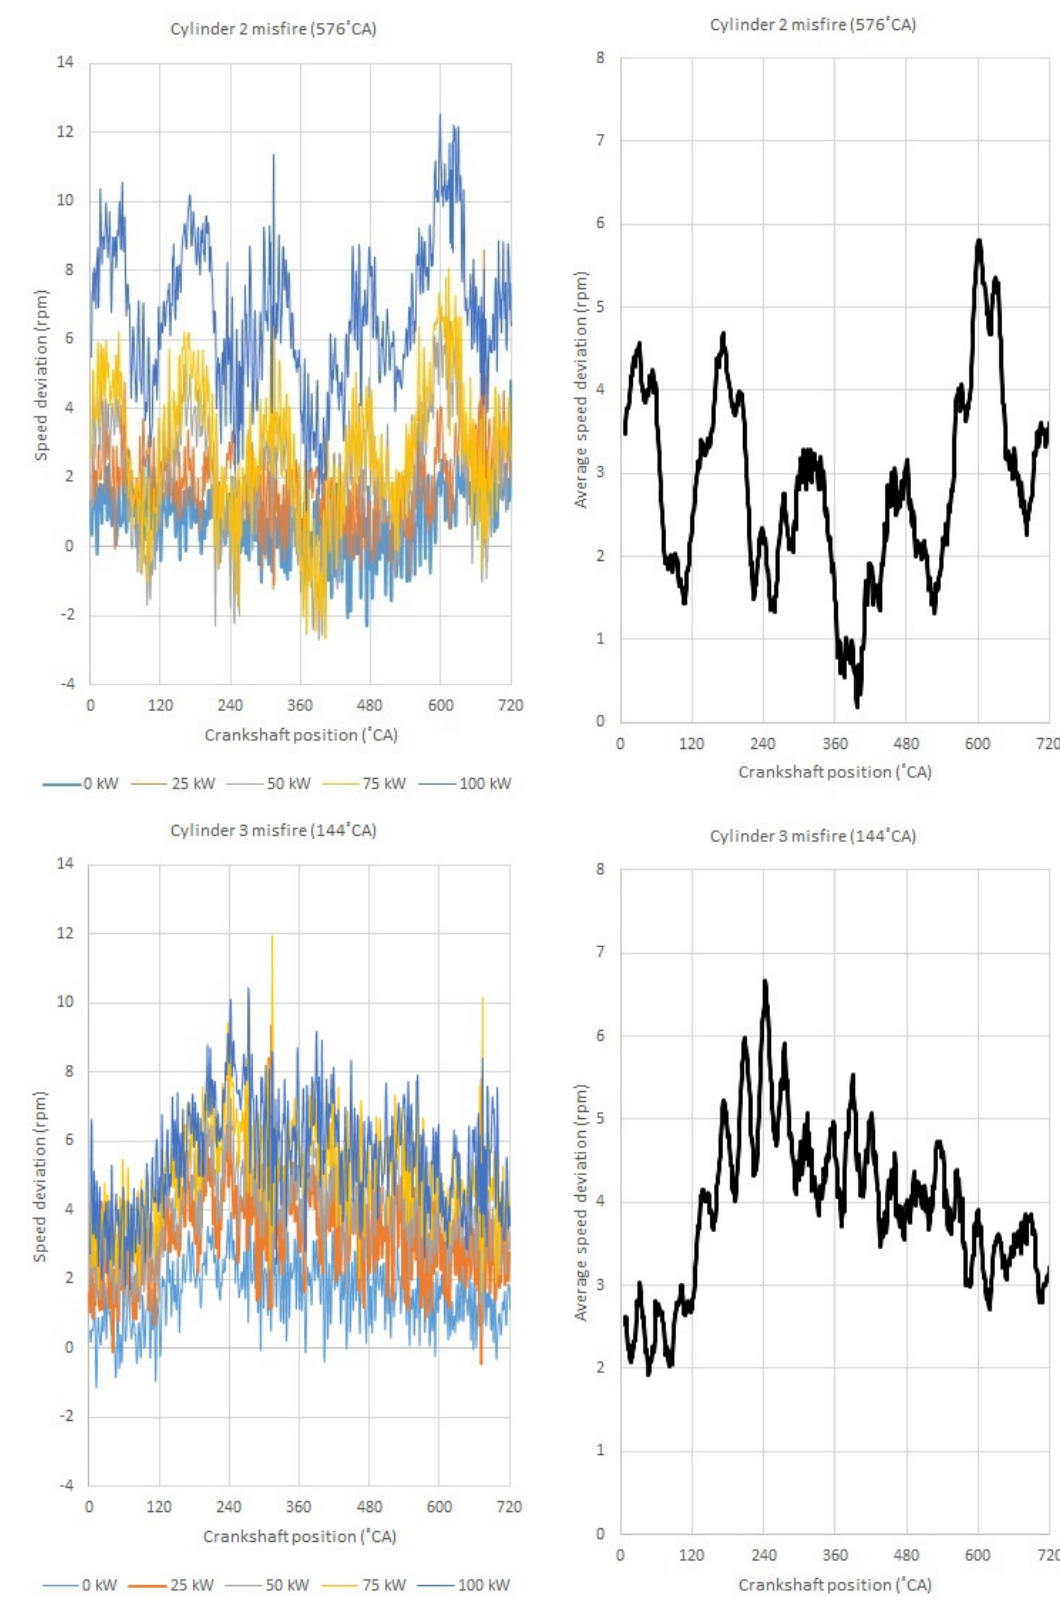
Figure 22. Instantaneous speed differences and the average deviation of the combustion process in cylinders 2 and 3 of a Sulzer 5 BAH 22 engine .